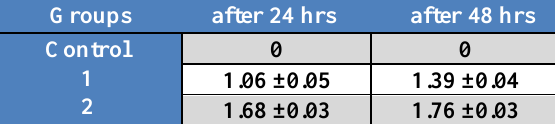
Table, 3: Shows mean values of antibodies titers against SSCAgs in immunized animals. Groups Means of Abs titers